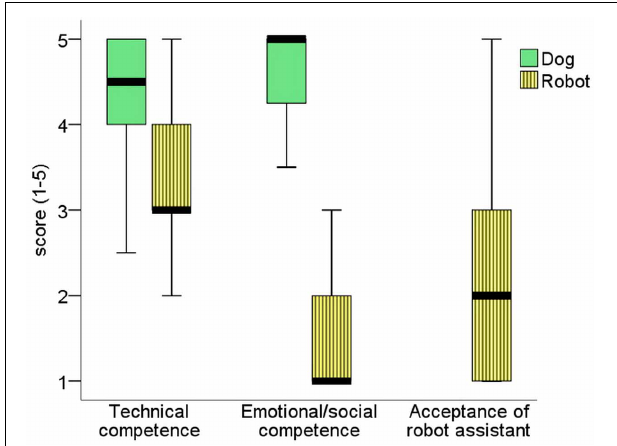
FIGURE 7 | The first two pairs of boxes present the scores owners gave to evaluate their dog’s work and emotional support (questions No 1, 2) and predict future assistance robot’s technical and social competences (No 9, 10). The last box displays owners’ attitude to use a modern assistance robot instead of the dog (No 8). The heavy black lines mark the median (50th percentile), the boxes mark the lower and upper quartiles, and the whiskers mark the minimum and maximum observed values that are not statistically